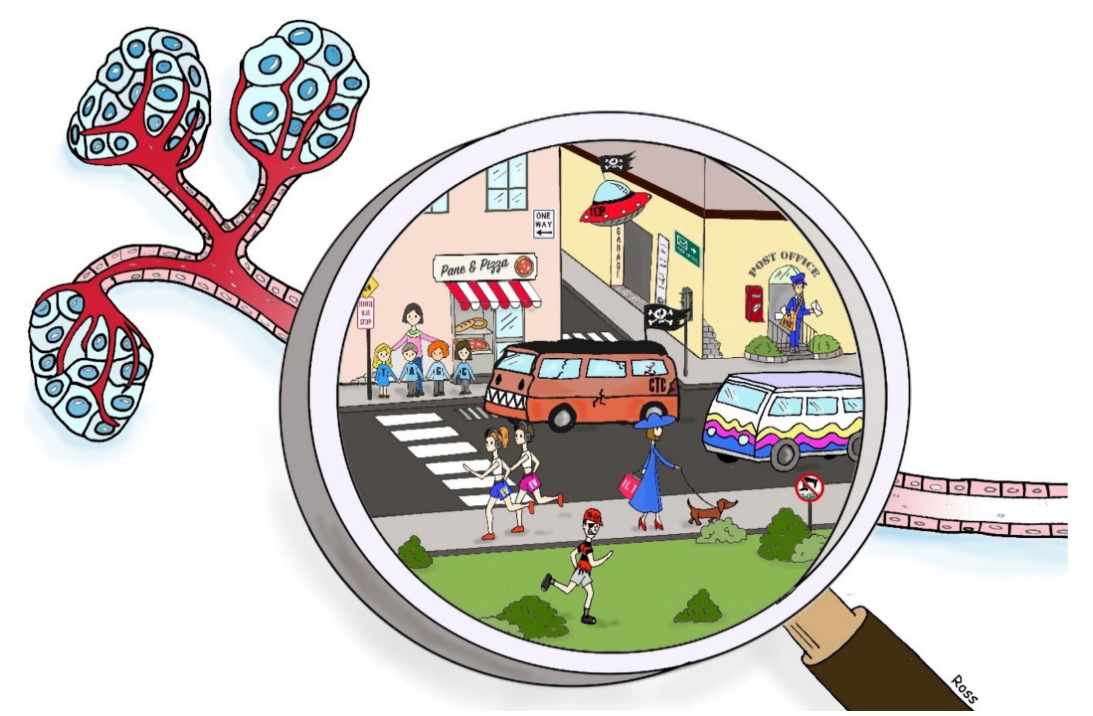
Figure 1. Cartoon representation of cancer circulome. Imagine observing a vessel coming from a tumor with a special magnifying glass. The vessel would appear as a lively neighborhood with the circulome components as main characters living their usual day. In front of a bakery and pizza restaurant, DNA nucleotides are pictured as kids accompanied by their teacher that are about to cross the road; they must pay attention to the red van (i.e., circulating tumor cell, CTC) that does not respect the highway code, unlike the colorful van (i.e., circulating cell, CC) that travels the road in peace. From the post o ffi ce, the postman (i.e., mRNA) is ready to carry messages and letters, while on the other side of the road two young girls (i.e., extracellular vesicles, E.V.s) are doing a fast run on the sidewalk near an elegant lady in a blue dress (i.e., Interleukin-1) that is walking slowly with her little dog. On the